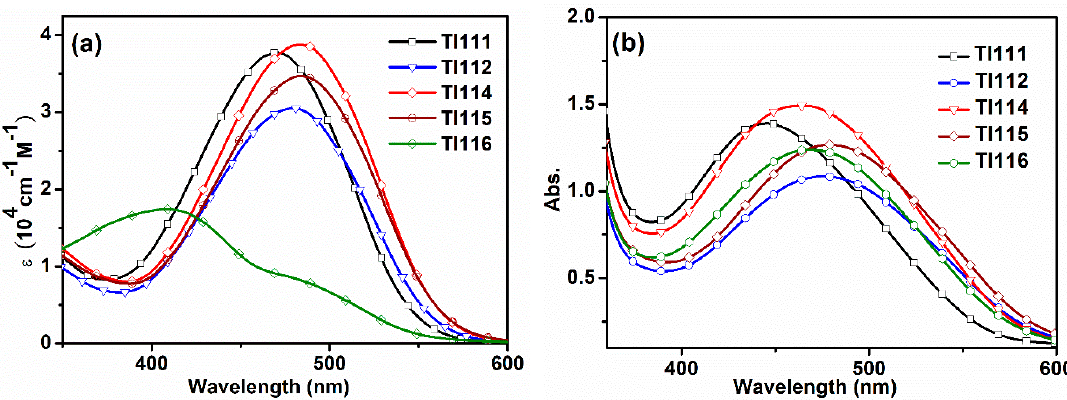
Figure 2. ( a ) Absorption spectra of TI111 - TI116 in CH 2 Cl 2 . ( b ) Absorption spectra for transparent TiO 2 films (thickness: 5 µm) coated with 8.0 × 10 − 5 M solutions of TI111 – TI116 .